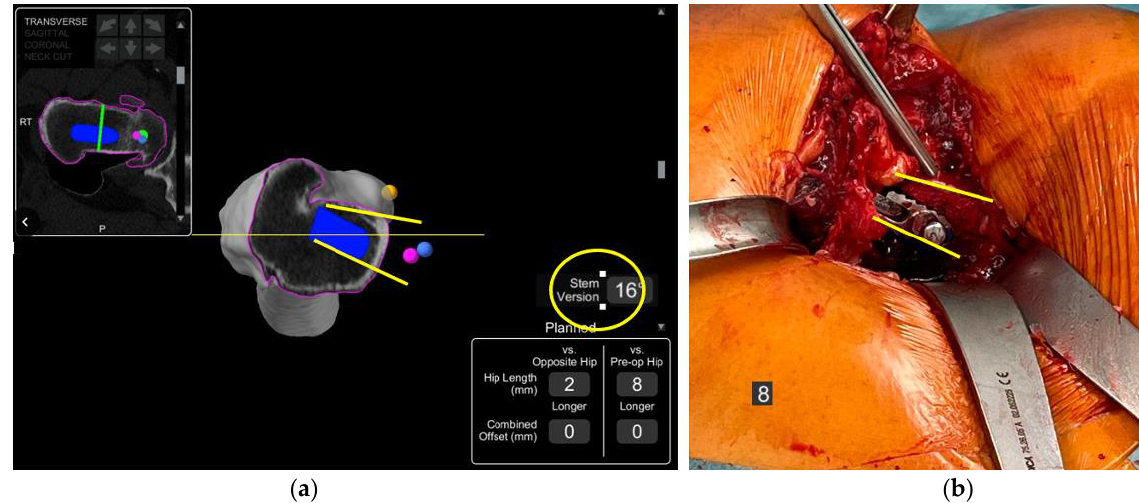
Figure 9. Correction of femoral retroversion from native − 6 degrees to +16 degrees with the implant on the ( a ) robotic software (yellow circle) and ( b ) intraoperatively (yellow lines).